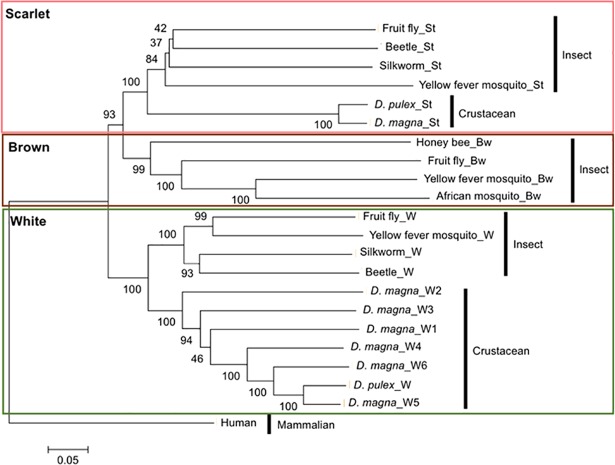
Phylogenetic tree of the amino acid sequences of eye pigment transporters.The percentages of the replicate tree in which the associated taxa clustered together in the bootstrap test (1,000 replicates) are shown next to the branches. The bar indicates branch length and corresponds to the mean number of differences (P < 0.05) per residue along each branch. Evolutionary distances were computed using the p-distance method. The accession number of each protein is shown in S1 Table.